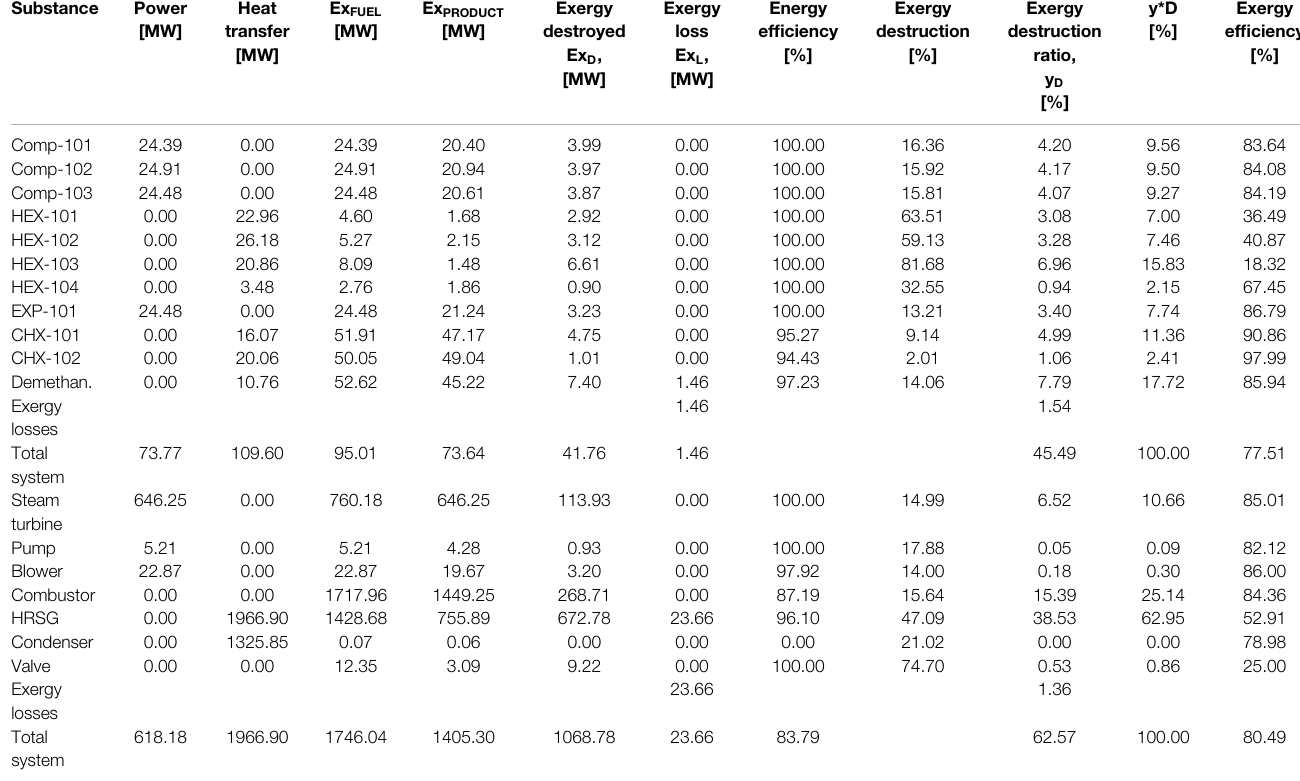
TABLE 5 | Fuel and product exergy of components of the integrated plant. Substance Power